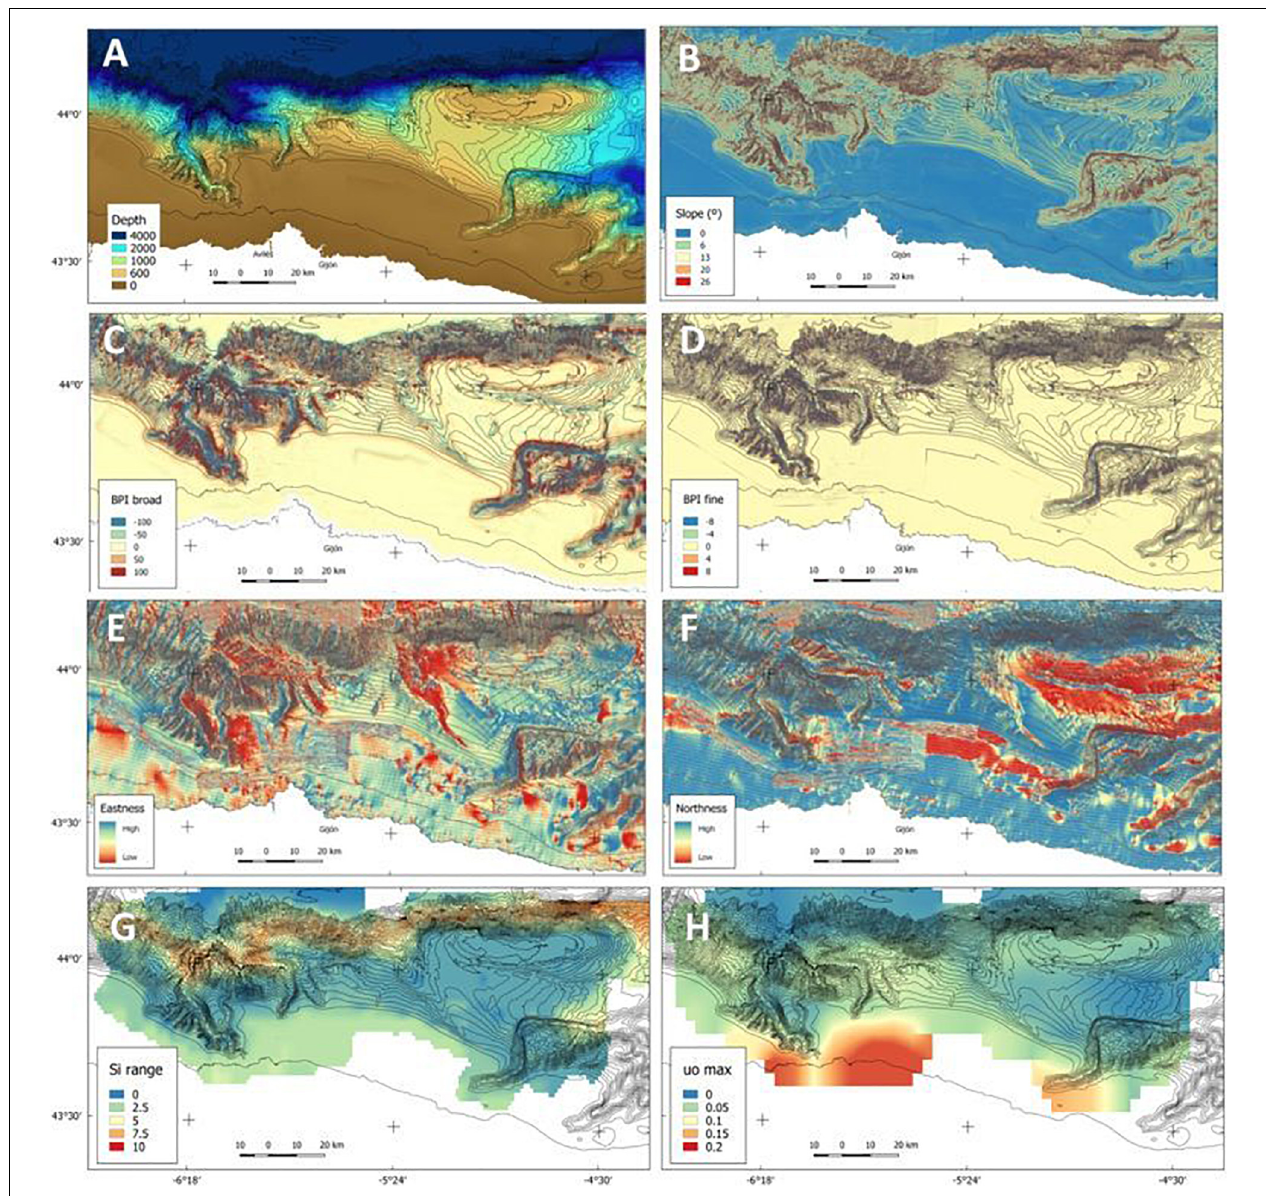
FIGURE 4 | DEM of the study area and layers used for the models: the geomorphological predictors depth (A) , slope (B) , BPI broad (C) and fine (D) scale, eastness (E) and northness (F) , and two of the physicochemical layers: silicates range (G) , and eastwards bottom current component (H)